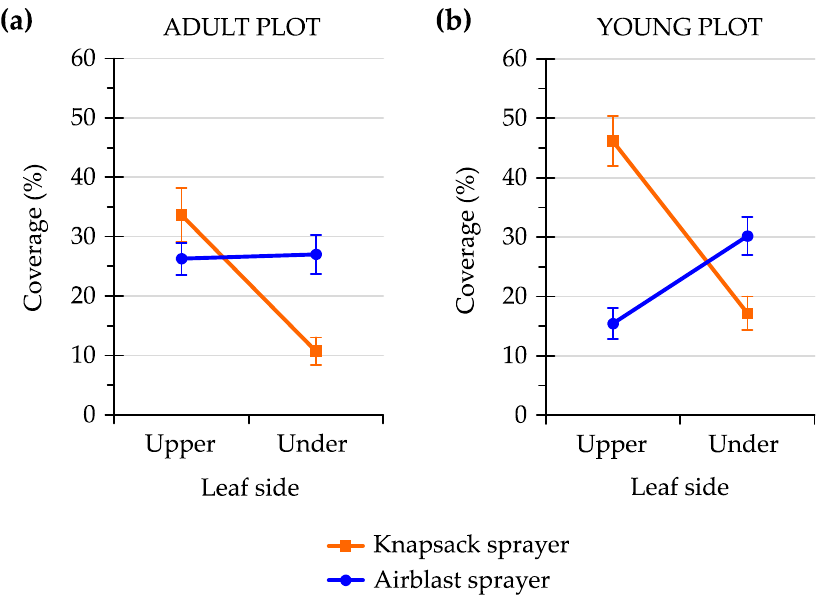
Figure 12. “Sprayer × Leaf side” interaction for coverage (%) (mean (s.e.)) for the ( a ) adult and ( b ) young plots. Table 9. Multifactor ANOVA results for the o ff -target losses ( µ L cm − 2 ) in the adult and young plots (LSD test, p < 0.05) a